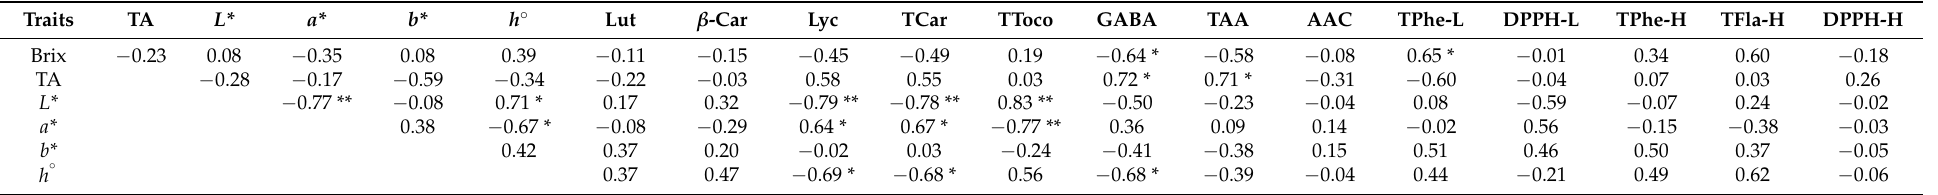
Table 3. Pearson’s correlation coefficients from physicochemical data, the contents of antioxidant constituents, and antioxidant activities of ten regular tomato cultivars.